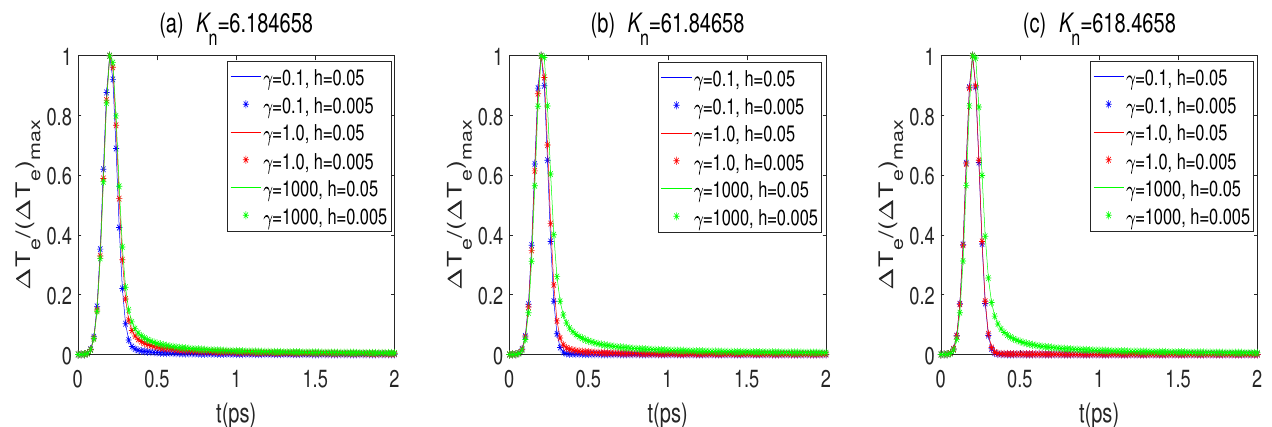
Figure 8. Changes in electron temperature ∆ T e / ( ∆ T e ) max and various K n , γ , and ( α , β ) = ( 0.4,0.6 ) .